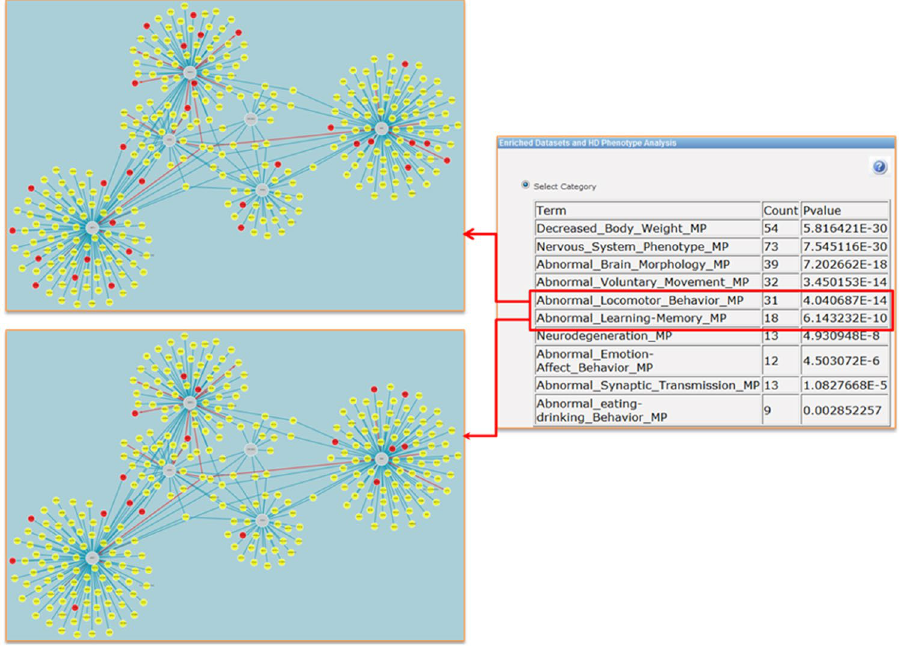
Figure 4. Phenotypic enrichment analysis. HD-relevant mammalian phenotypes are listed, for which a significant enrichment among components of the UPR interactome was detected. Highlighted phenotypes are “Abnormal Locomotor Behavior” and “Abnormal Learning Memory”. Red nodes represent the genes or proteins annotated with these HD-relevant phenotypes in